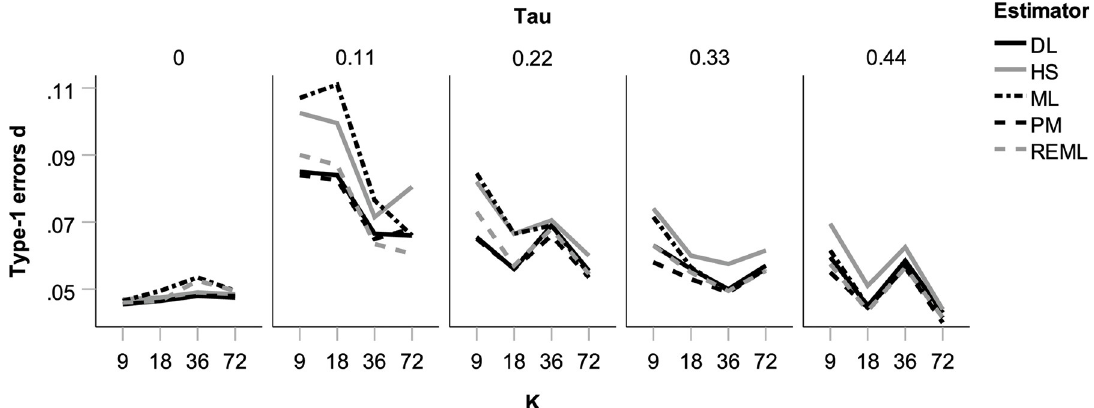
Fig 1. Proportion of type-1 errors for overall effect size estimate d in the absence of publication bias and p -hacking for five heterogeneity estimators as a function of true heterogeneity ( τ ) and number of studies per meta-analysis ( k ), with α -level = 0.05.